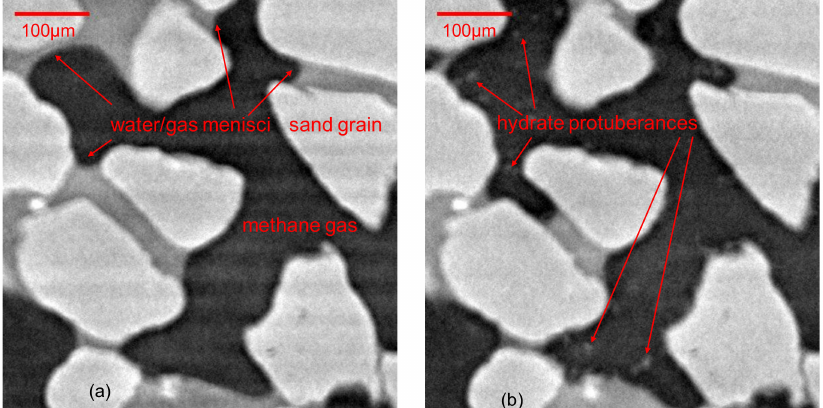
Figure 3. Early stages of methane hydrate growth, results of run 1: ( a ) Image on reaching 1–2 ◦ C; ( b ) Methane hydrate is visible in an image taken 0.58 h